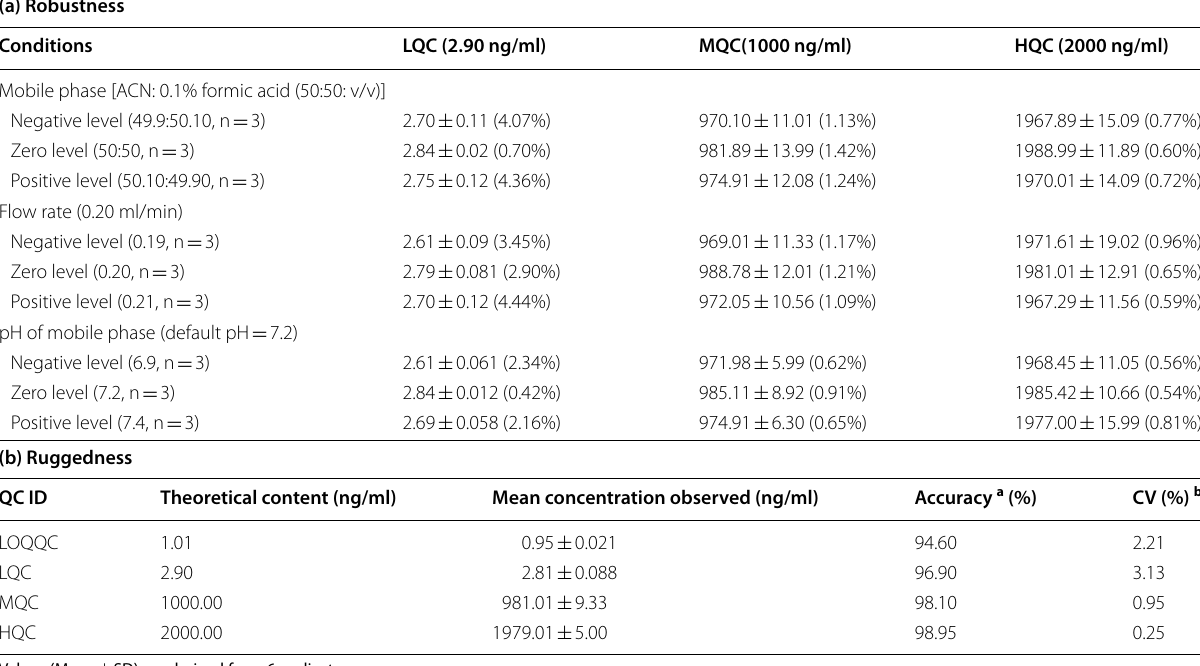
Table 2 Robustness of the method for doxorubicin (DOX)